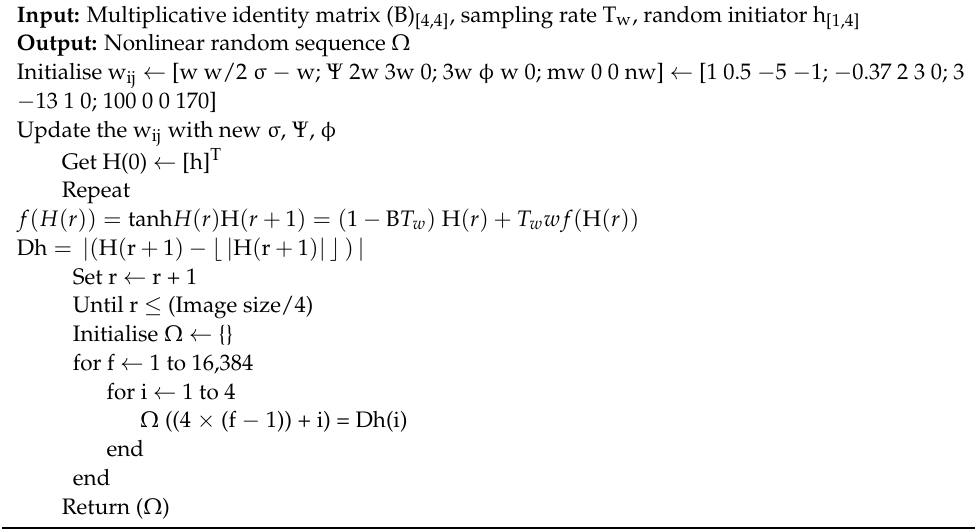
Algorithm 1: Adaptive random sequence generation using discrete Hopfield attractor